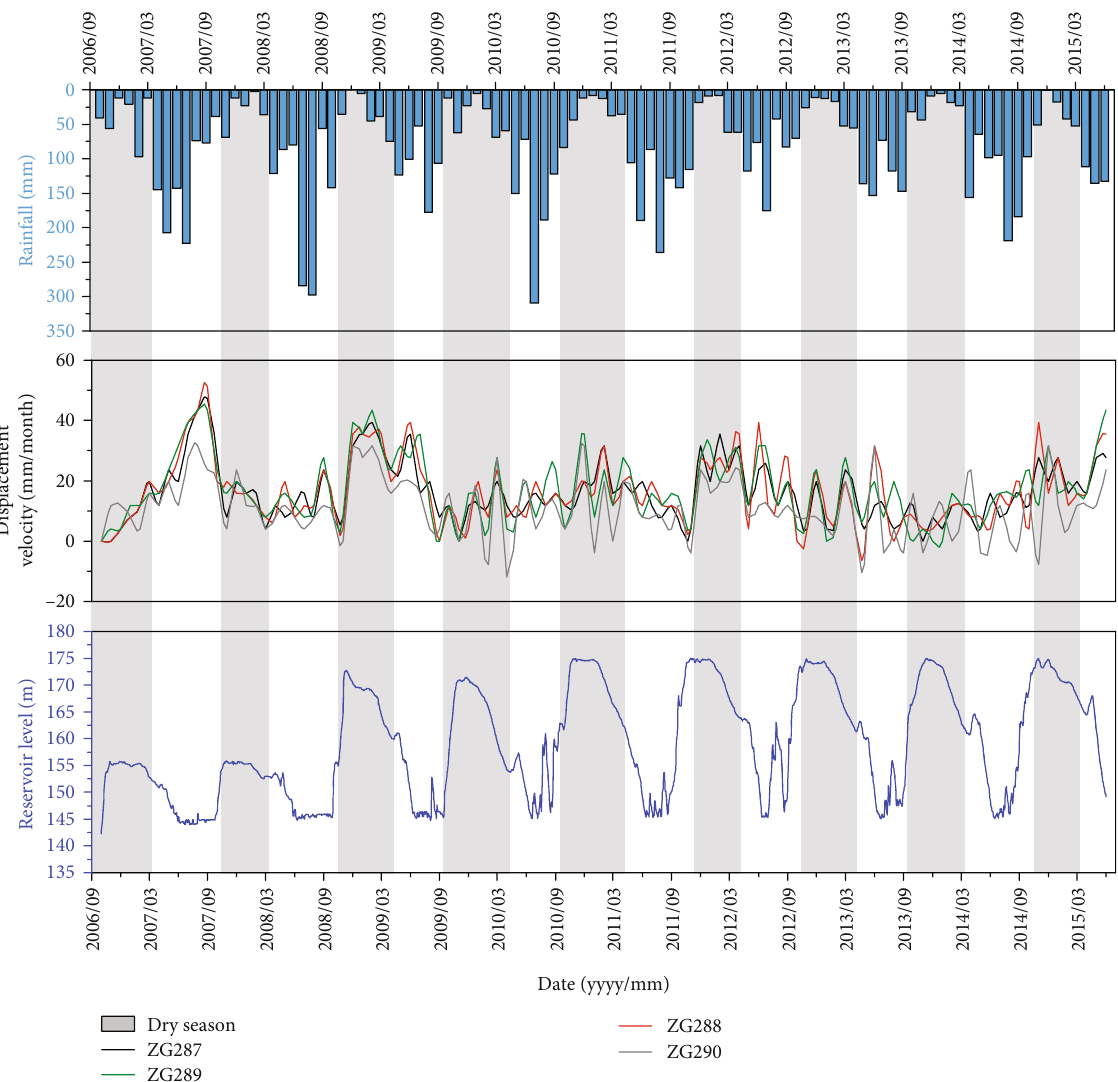
Figure 5: Correlation analysis between the displacement velocity and reservoir level and